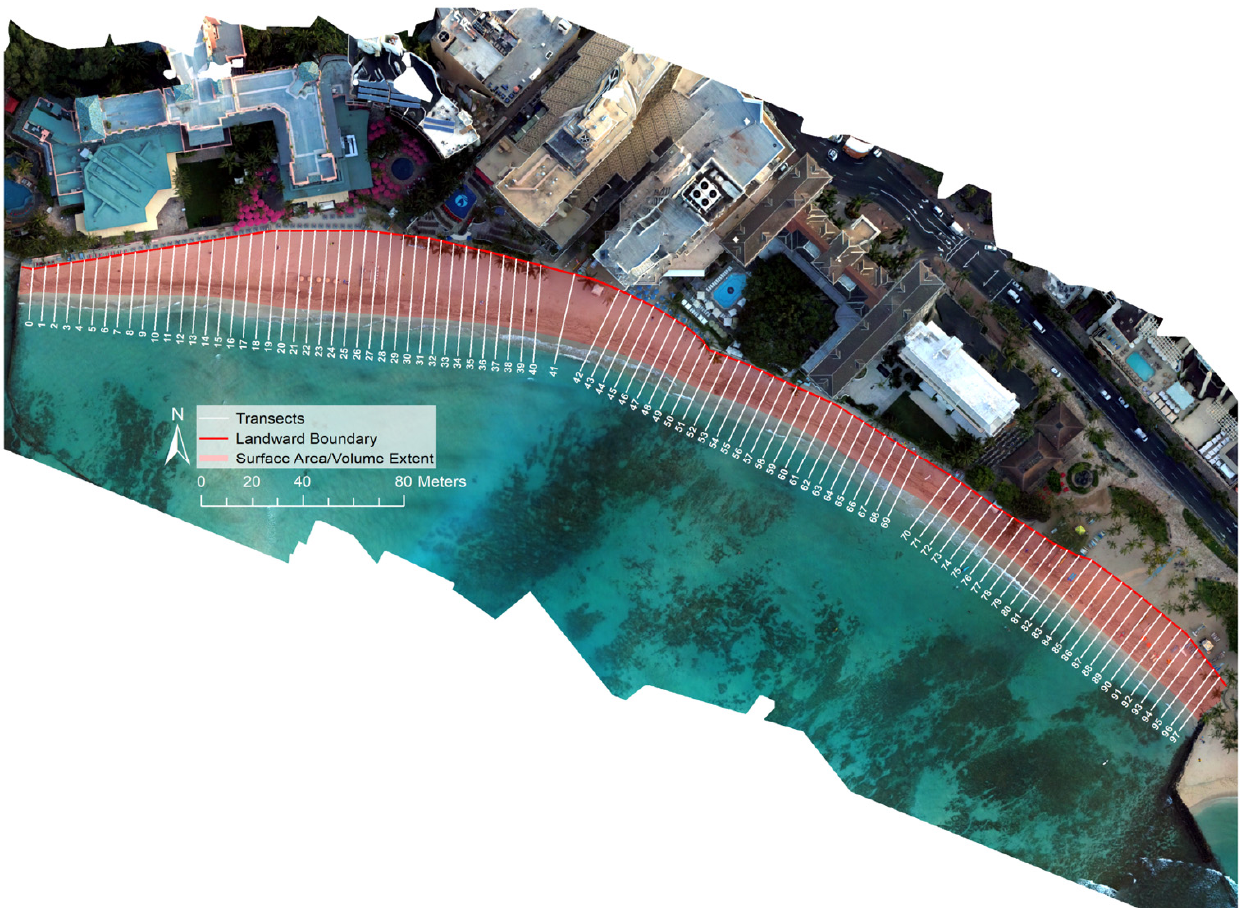
Figure 6. To determine beach width, transects were cast at 5-m intervals along the beach. Beach width was defined as the distance between the seaward edge of the beach (where the beach surface intersects the MHHW elevation) and the inland edge of the beach (typically identified by cement walkways or other engineered structures) and calculated for each transect. The above figure represents transect IDs for the study area. For reference, Transect 0 is located at the west end of the study area adjacent to Royal Hawaiian Groin, while Transect 97 is at the east end adjacent to K¯uhi¯o Groin. The transparent overlay represents the extent of the beach above MHHW used for beach width, surface area, and volume calculations. Orthomosaic basemap generated from the 15 May 2018 aerial